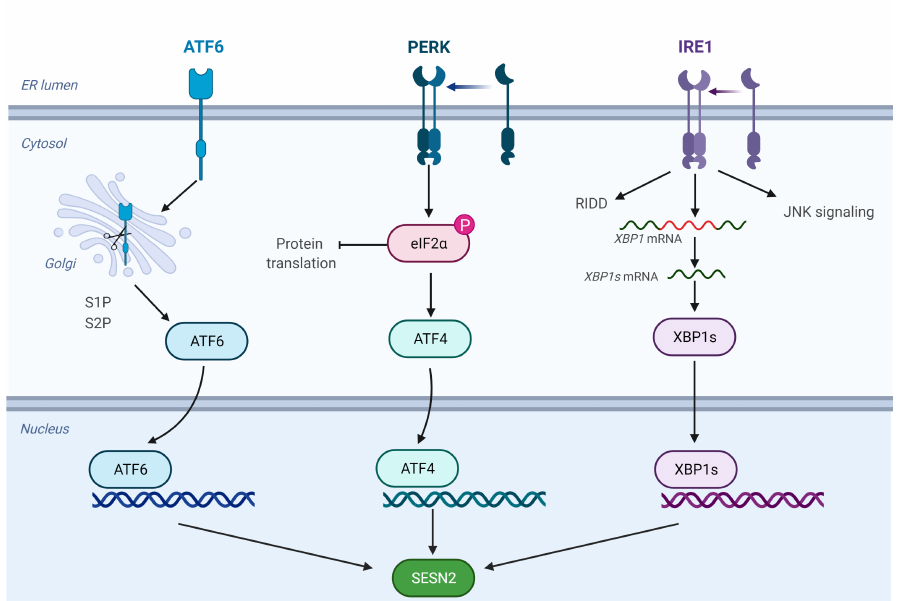
Figure 4. The regulation of SESN2 in response to ER stress. The UPR sensors—PERK, IRE-1 α , and ATF-6—remain inactive by binding to BIP under non-stressed conditions. Accumulation of misfolded proteins during ER stress results in the dissociation of BIP induces dimerization of PERK and IRE-1 α , as well as transport of ATF-6 to the Golgi apparatus. IRE-1 α endoribonuclease activity generates an important transcription factor XBP-1s, which enters the nucleus to regulate the expression of SESN2 . The severe and chronic ER stress response causes the activation of RIDD and JNK. PERK induces the phosphorylation of the α subunit of translation initiation factor 2 (eIF-2 α ), which blocks the translation initiation. PERK activation paradoxically promotes the transcription initiation of the gene encoding ATF-4 which induces SESN2 . ATF-6 moves to the Golgi apparatus and undergoes stepwise cleavage by S1P and S2P proteases to generate an active form that mediates transcriptional induction of SESN2 . ATF-4: Activating Transcription Factor 4; ATF-6: Activating Transcription Factor 6;